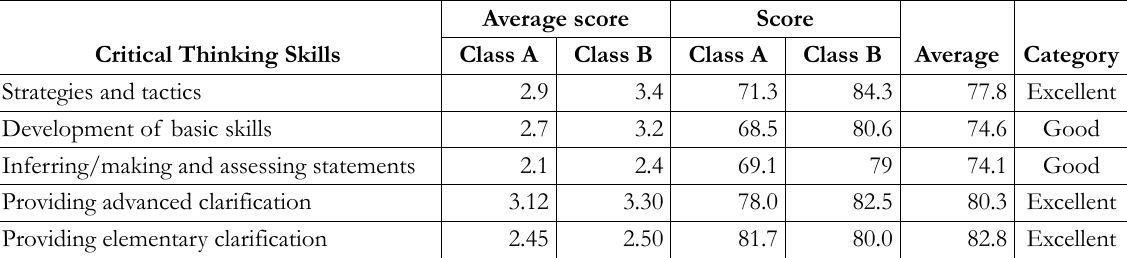
Table 4. Students’ critical thinking skills in chemistry learning development (P3K) course